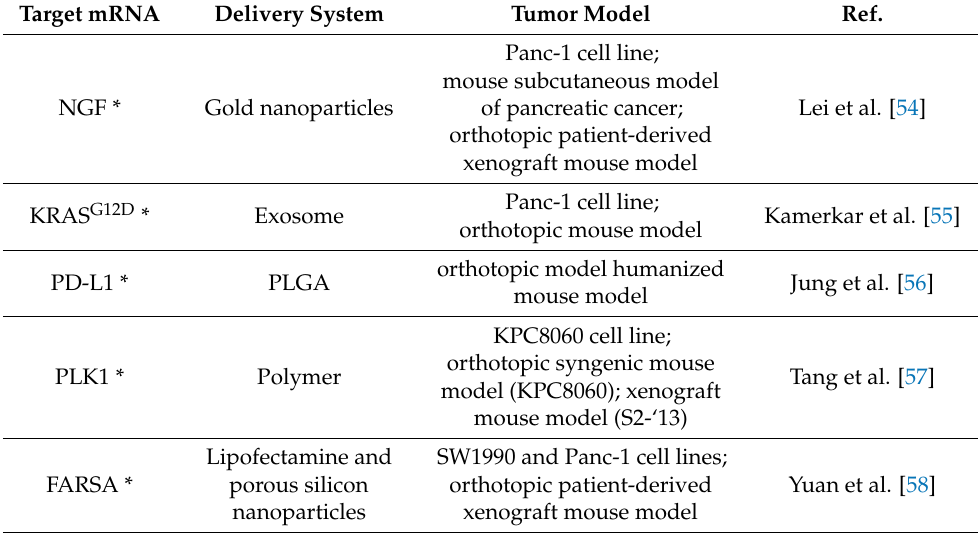
Table 3. siRNA employment in pancreatic